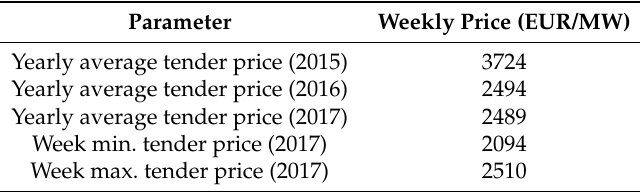
Table 1. Primary control reserve (PCR) market data summary. Tender prices displayed are mean values for winning bids of weekly auctions. Extremum weeks and average yearly values are